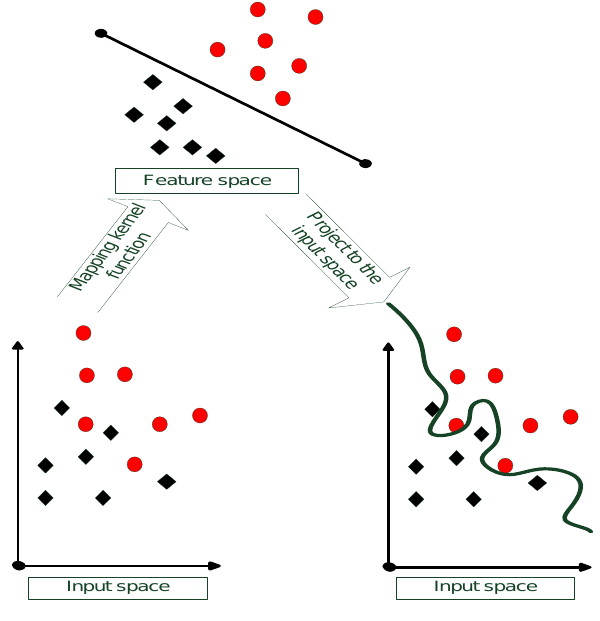
Figure 5. The concept of support vector machine